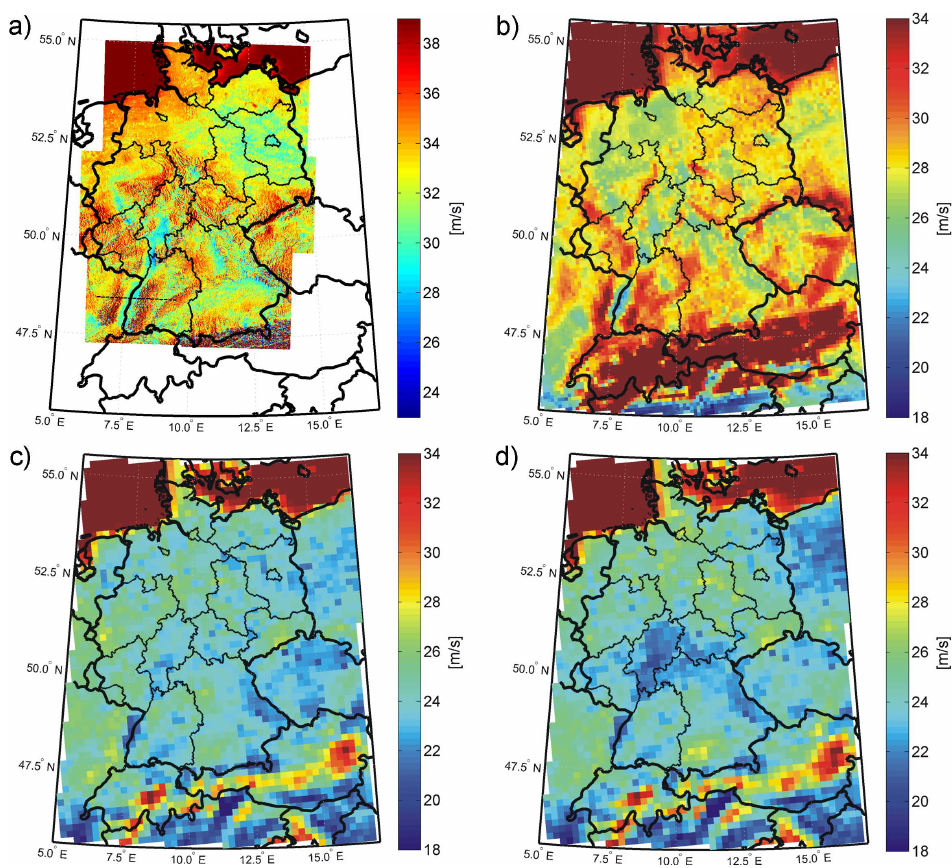
Fig. 5. Maximum gust wind speeds for a 10-year return period from CSHM (a) , REMO (b) , CCLM1 (c) , and CCLM2 (d) . Note the different scales of the color